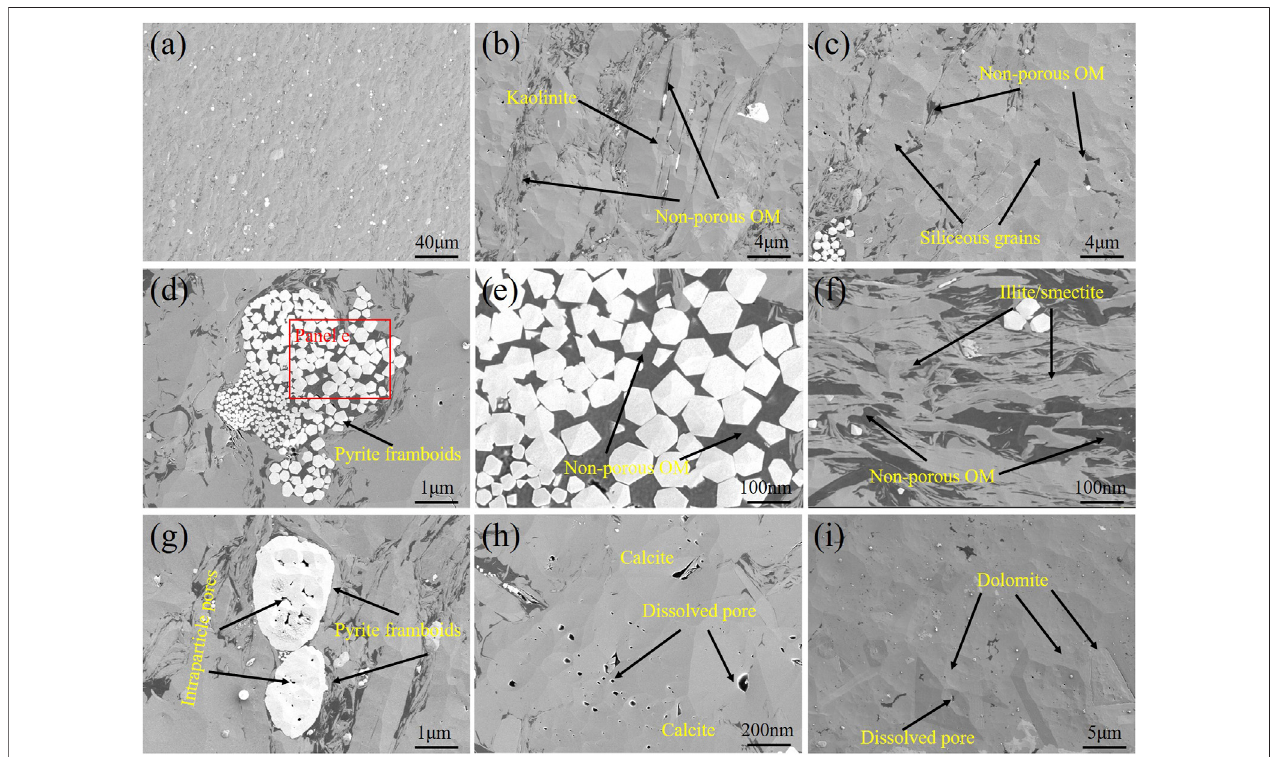
FIGURE 8 | FIB-SEM images of the Lower Cambrian shales. (A – C) OM mixed with matrixes as stripes and wisp (#C1), (D,E) nonporous OM inside of pyrite framboids(#C4), (F) aggregatesofOMandillite/smectite(#C5), (G) intraparticle poresinsidepyriteframboids(#C4), (H,I) dissolvedporesonthesurfaceofcalcite(#C7), and dolomite